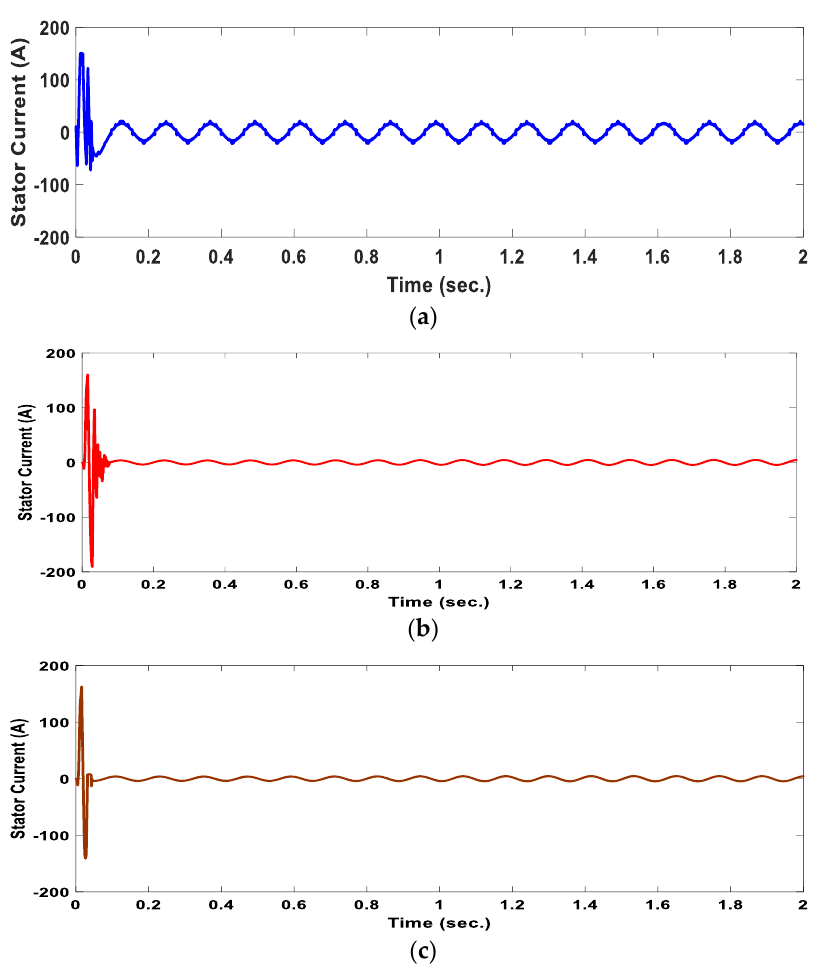
Figure 18. The stator current for the desired speed of 50 rad/s at zero load for the ( a ) PI-based PSO, ( b ) PSO with fuzzy PID, and ( c ) fuzzy-PID-based C-BO.